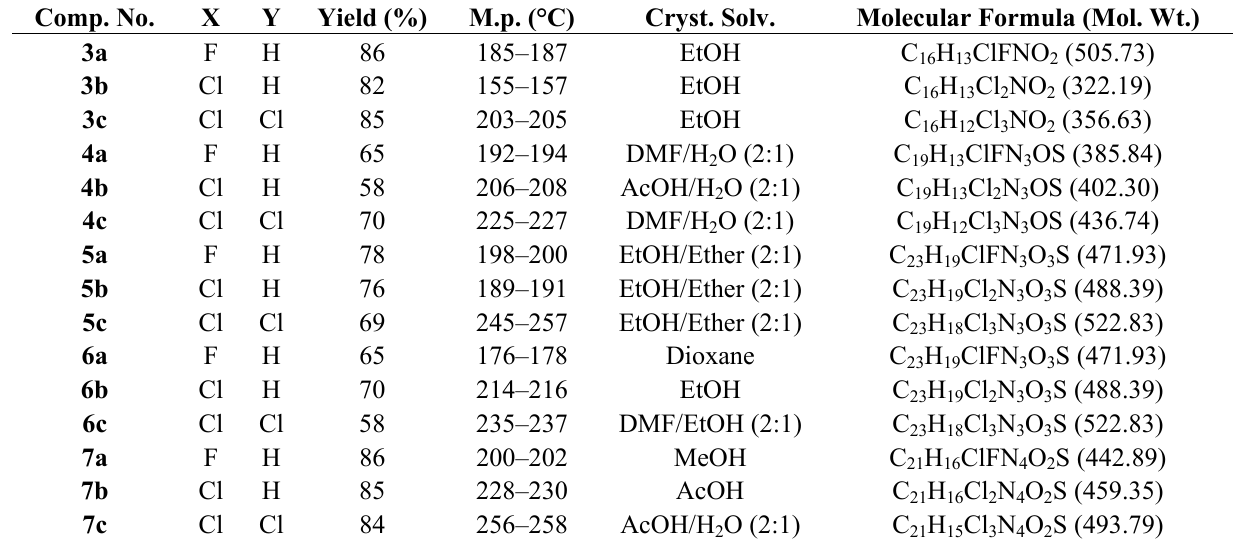
Table 1. Melting points, crystallization solvents, yields, molecular formulae and molecular weights of compounds 3 – 7